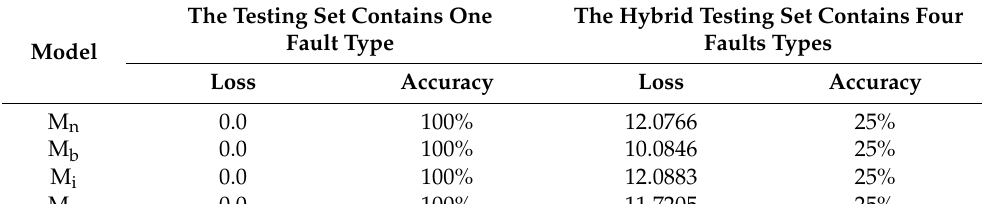
Figure 4. Loss and accuracy curve of federated fault diagnosis model.